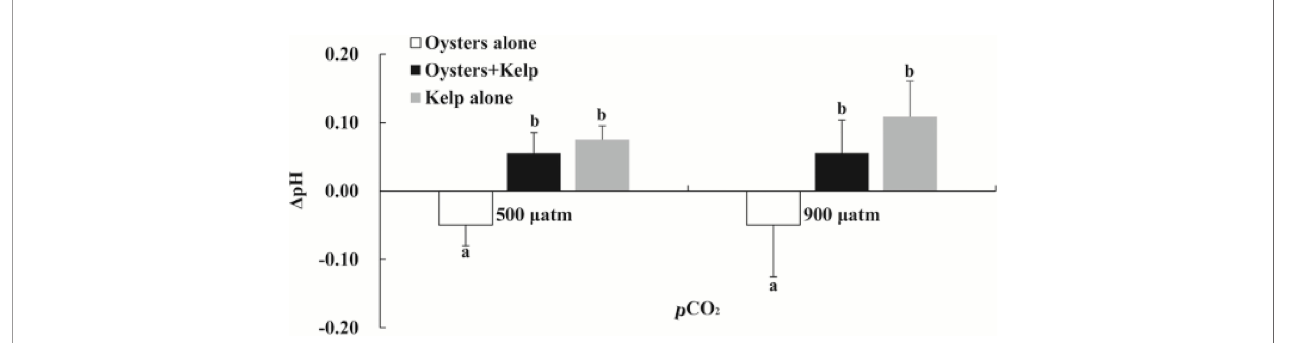
FIGURE 3 | Average change in daytime pH NBS in the in fl ow and out fl ow of experimental units across the treatments during the 30 days. Means ± SD are presented. Different letters indicate signi fi cant variation between culture treatments ( P